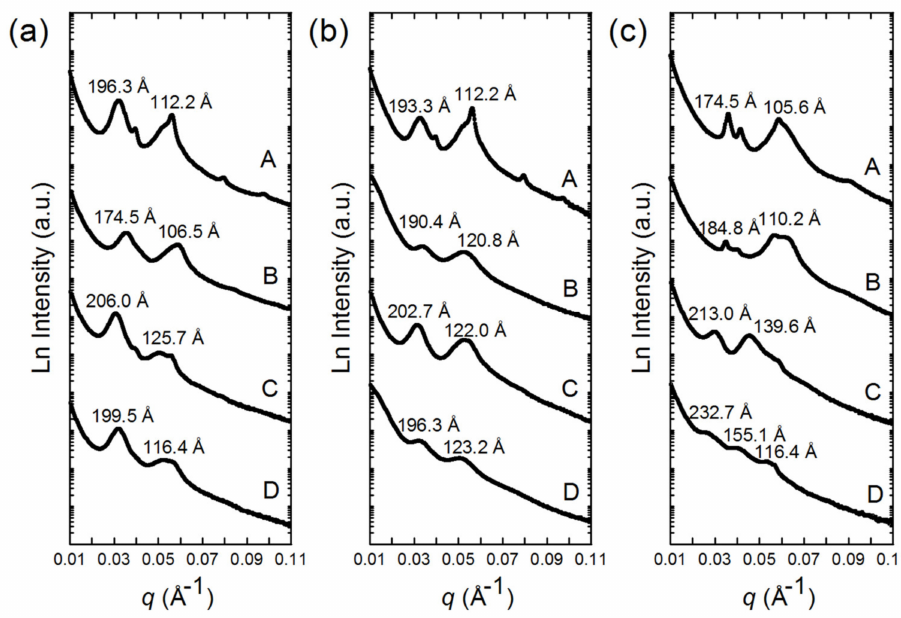
Figure 6. SAXS patterns of mesoporous organosilica samples: PMOFH-1 ( a-A ), PMOFH-2 ( a-B ), PMOFH-3 ( a-C ), PMOFH-4 ( a-D ), PMOAH-1 ( b-A ), PMOAH-2 ( b-B ), PMOAH-3 ( b-C ), PMOAH-4 ( b-D ), PMOBH-1 ( c-A ), PMOBH-2 ( c-B ), PMOBH-3 ( c-C ), PMOBH-4 ( c-D ). Table 3. Physicochemical properties of mesoporous silica/organosilica samples a